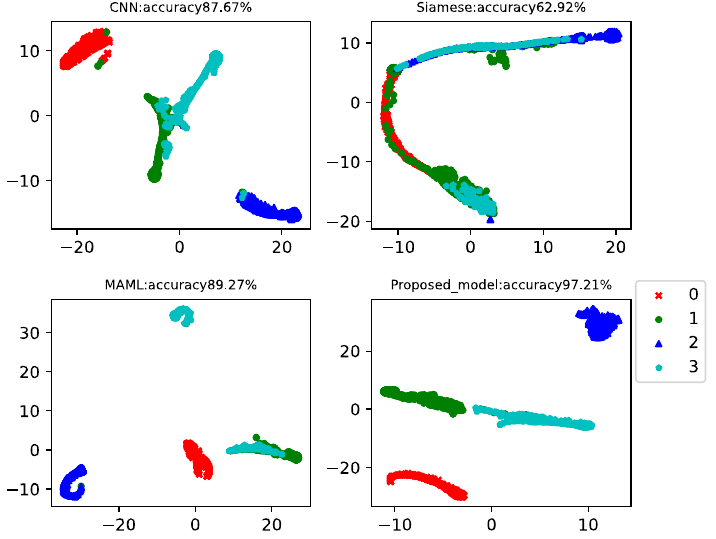
Figure 6. Four-way-five-shot diagnosis of the CWRU data for different algorithms.